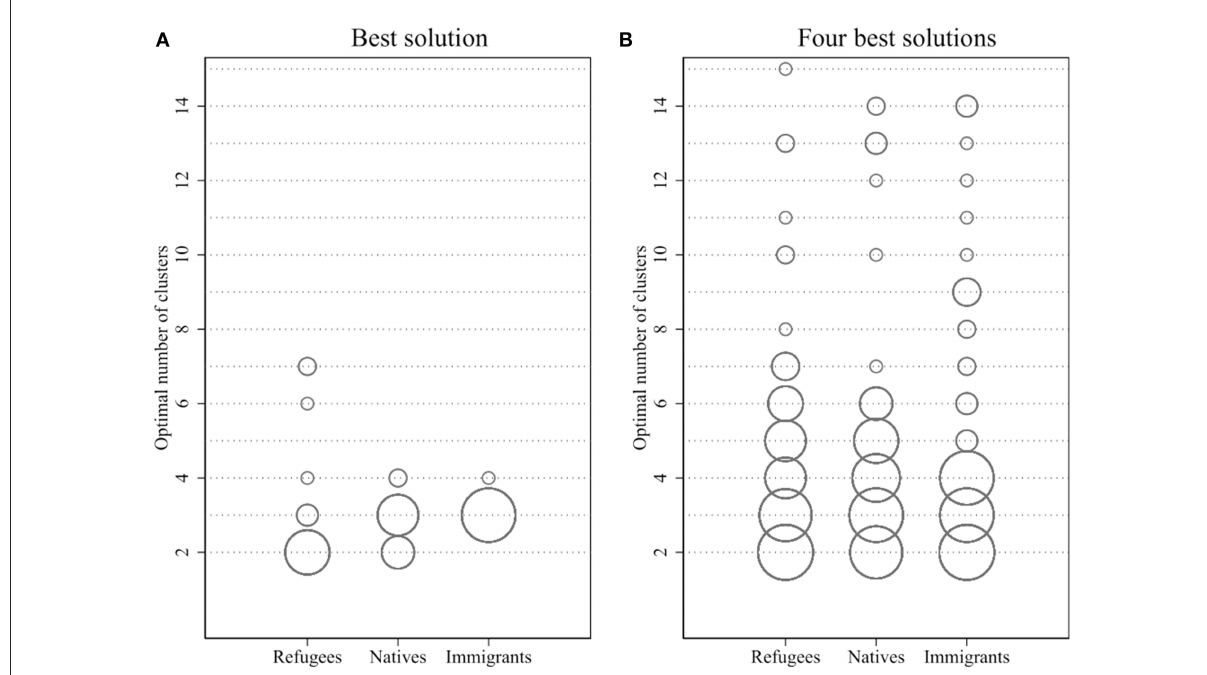
FIGURE1 Optimal number of clusters by population group. Circle size represents frequency, with larger circles representing higher frequency. (A) Best solution. (B) Four best